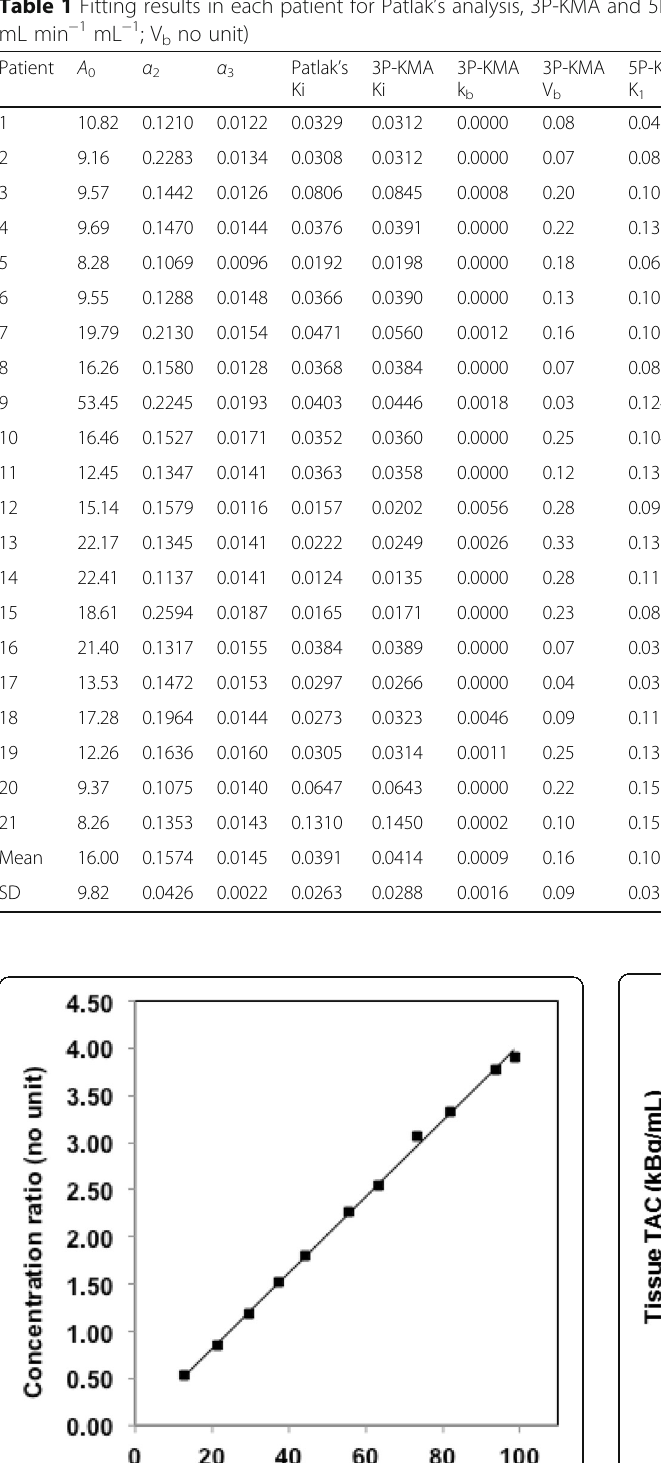
Table 1 Fitting results in each patient for Patlak ’ s analysis, 3P-KMA and 5P-KMA ( A 0 in kBq mL − 1 ; α 2 , α 3 , k b k 2-4 in min − 1 ; Ki and K 1 in